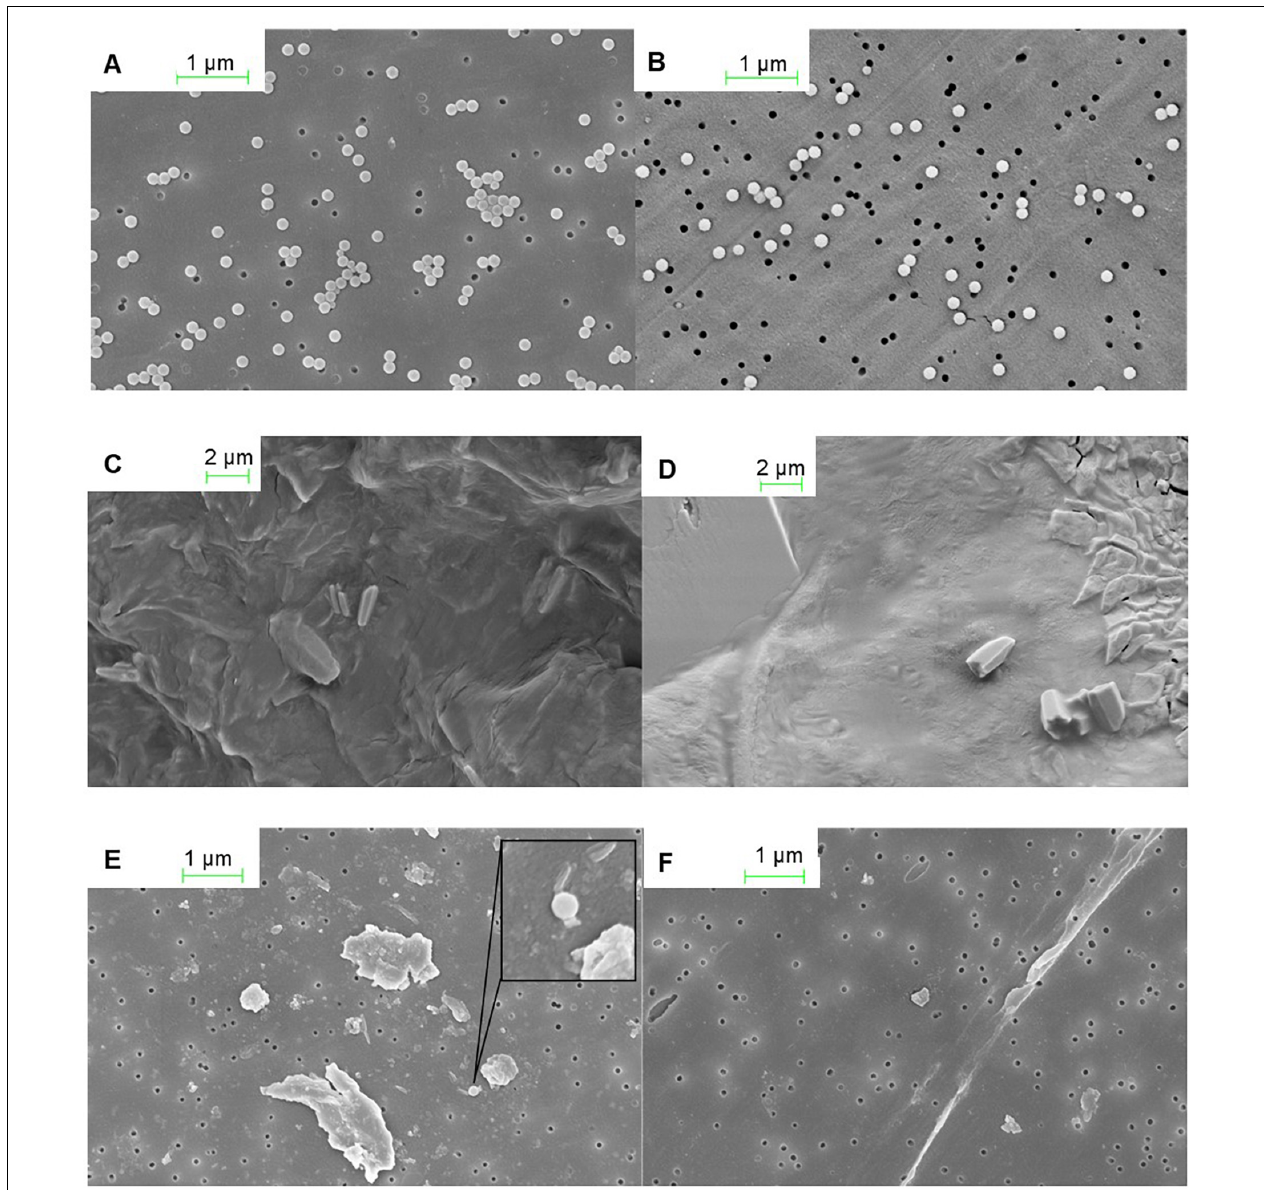
FIGURE 1 | SEM images from nanoplastic investigations of the krill chorion and residual of digested krill embryos. (A) Nanoplastic stock diluted with Milli-Q on a polycarbonate membrane. (B) Nanoplastic stock diluted with Milli-Q on polycarbonate membrane post treatment with10% KOH (60 ◦ C, 48 h) to mimic the krill egg digestion. (C) Chorion of a krill embryo from the control treatment. (D) Chorion of a krill embryo from the plastic treatment. (E) Digested (10% KOH, 60 ◦ C, 48 h) krill egg residual on a polycarbonate membrane of embryos Milli-Q cleansed. (F) Digested (10% KOH, 60 ◦ C, 48 h) krill egg residual on polycarbonate membrane of embryos Milli-Q and ethanol cleansed. SEM images are courtesy of Christian Hacker, University of